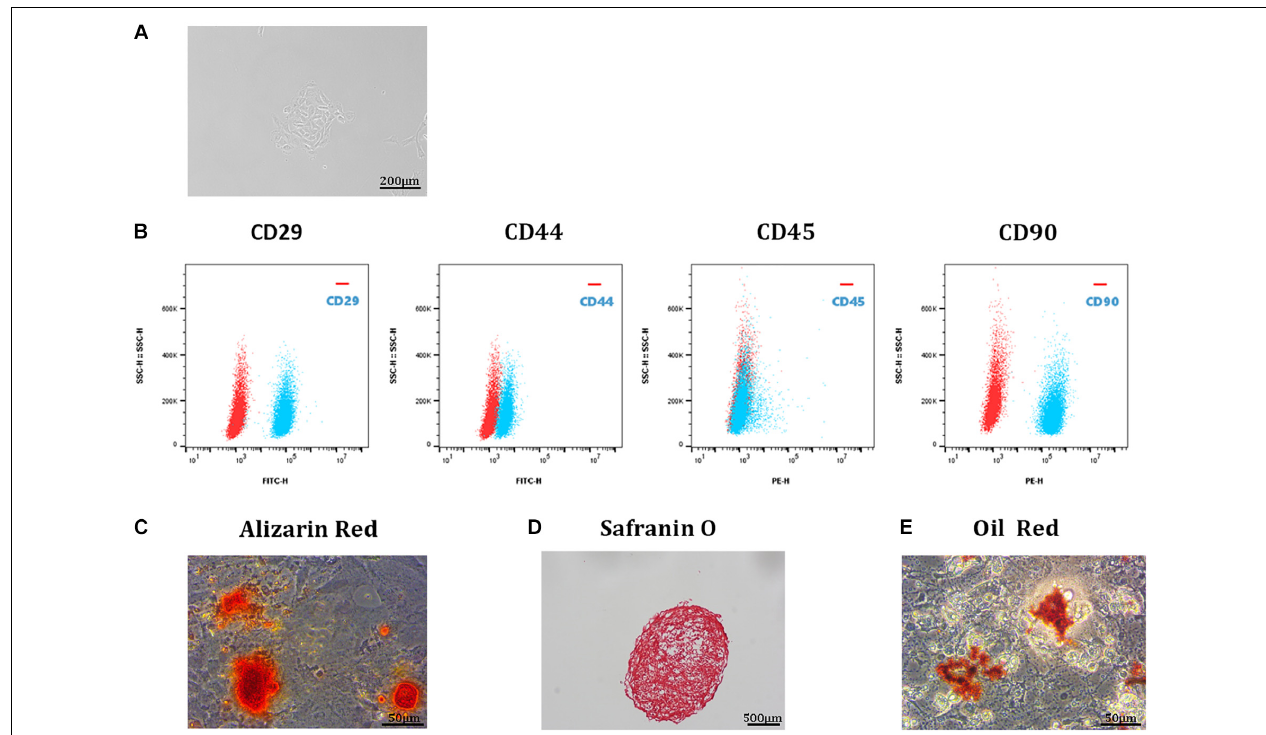
FIGURE 1 | Isolation and identification of TDSCs. (A) A single-cell suspension of 1 cell/ µ L was prepared and cultured in a 12-well plate at 37 ◦ C with 5% CO 2 . These TDSCs were able to form small colonies and were photographed at 4 day. Scale bar, 200 µ m. (B) Representative flow cytometric profiles of TDSCs stained for the surface markers CD29, CD44, CD45, and CD90 (red: control; blue: fluorescent antibody). Scale bar, 500 µ m. (C) Alizarin Red staining of TDSCs osteogenic differentiation. Scale bar, 50 µ m. (D) Safranin O staining of TDSCs chondrogenic differentiation. Scale bar, 500 µ m. (E) Oil Red staining of TDSCs adipogenic differentiation. Scale bar, 50 µ